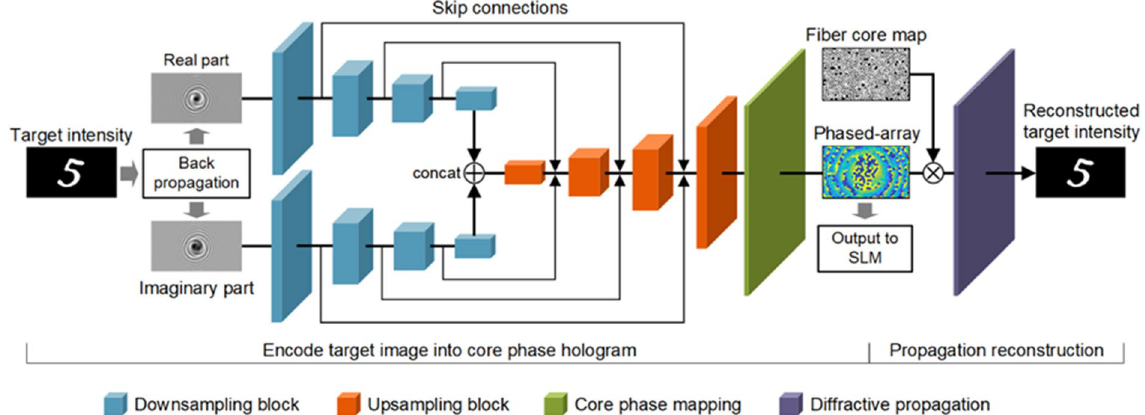
Figure 1. Structure of the phase encoder deep neural network (CoreNet). The encoding part of CoreNet is a modified U-Net. The downsampling path of U-Net is split into two paths, and the inputs of the two paths are the real and imaginary parts of the field at the distal facet of the fiber bundle, which is obtained by back-propagation of the target field to the plane of the distal fiber facet. The core phase mapping and diffractive propagation are embedded in CoreNet to reconstruct the target field. Since the labeled data is the same as the input target field, CoreNet can achieve unsupervised learning.